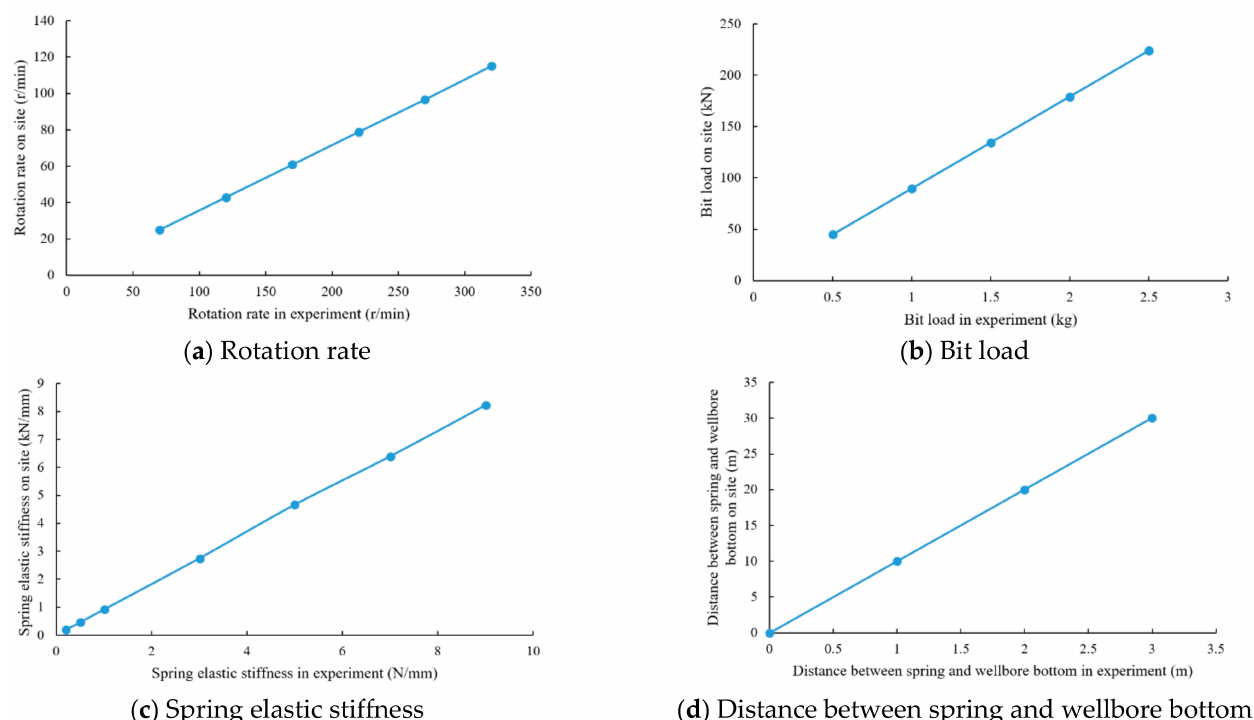
Figure 5. The relationship between experimental parameters and actual